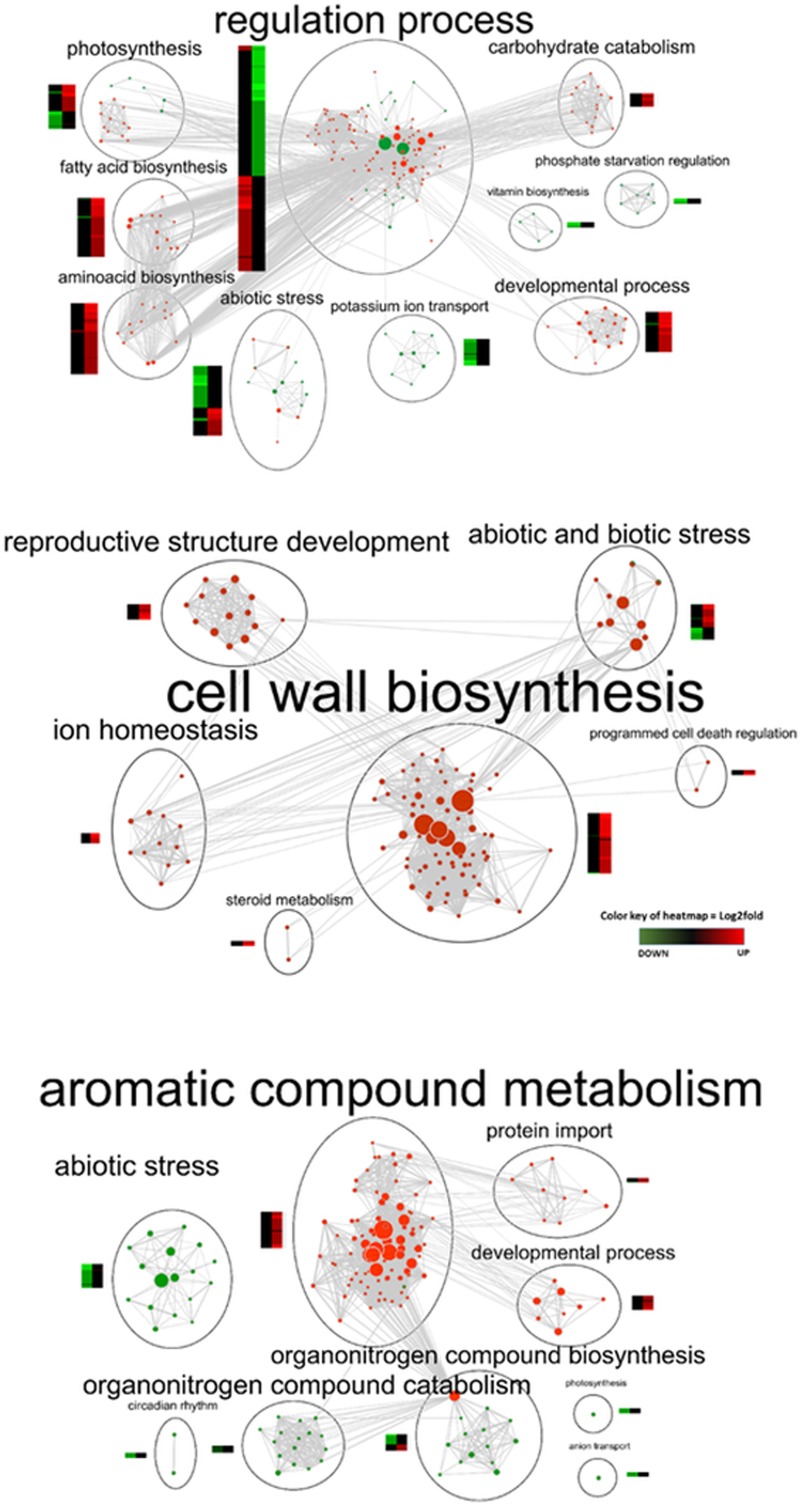
Enrichment map of genes expressed under the Reduced Rainfall treatment with no fertilization (A), with K fertilization (B), with Na fertilization (C). The map includes nodes representing GO enriched gene sets connected by their edges, representing similarity between two gene sets. Nodes belonging to very similar biological processes were clustered and labeled with a summarized name. For each cluster, the heatmap of up- and down-expressed genes in response to RR is shown. Enrichment significance (p-value) is conveyed by the node color in the corresponding up and down-expressed genes; enrichment significance (p-value) is conveyed by the size of the node, which is proportional to the number of up-and down-expressed genes; the edge thickness is proportional to the degree of similarity between two nodes. HeatMap: the color represents positive and negative log2 fold changes in gene expression.